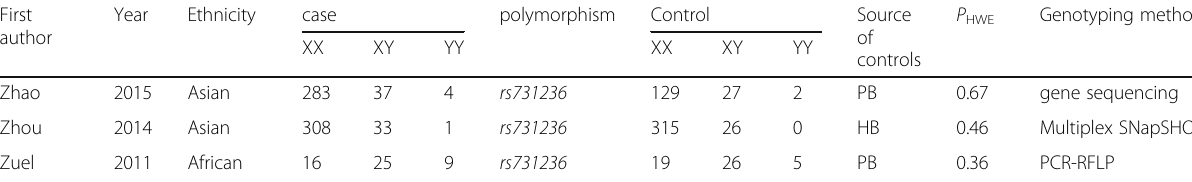
Table 1 Genotype distributions of included case-control studies